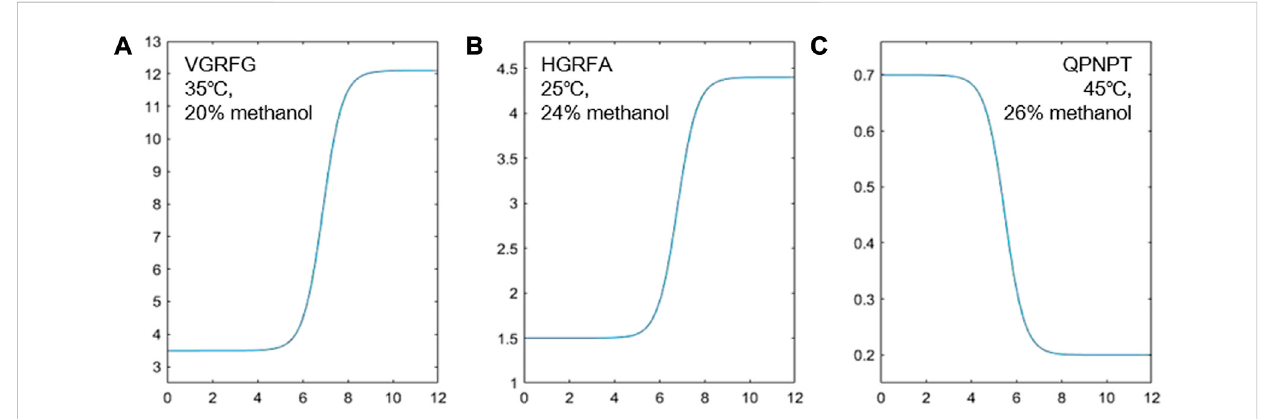
FIGURE 1 Fitting of the experimental retention and different pH values of VGRFG at 35 ° C and 20% methanol (A) , HGRFA at 25 ° C and 24% methanol (B) , and QPNPT at 45 ° C and 26% methanol (C) .